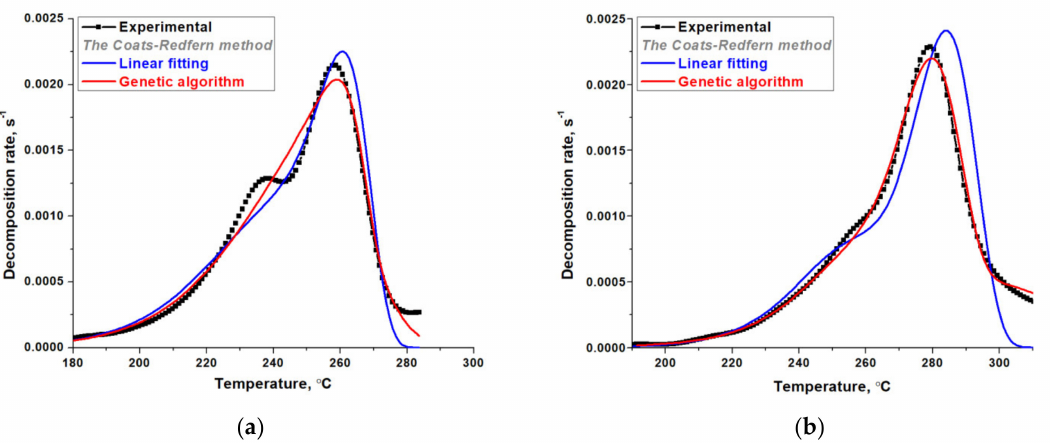
Figure 5. Modelling the thermal decomposition of ( a ) [Ni(C 3 H 4 N 2 ) 6 ](NO 3 ) 2 and ( b ) [Ni(C 3 H 4 N 2 ) 6 ] (ClO 4 ) 2 complexes using the Coats–Redfern method. The heating rate in air is 5 ◦